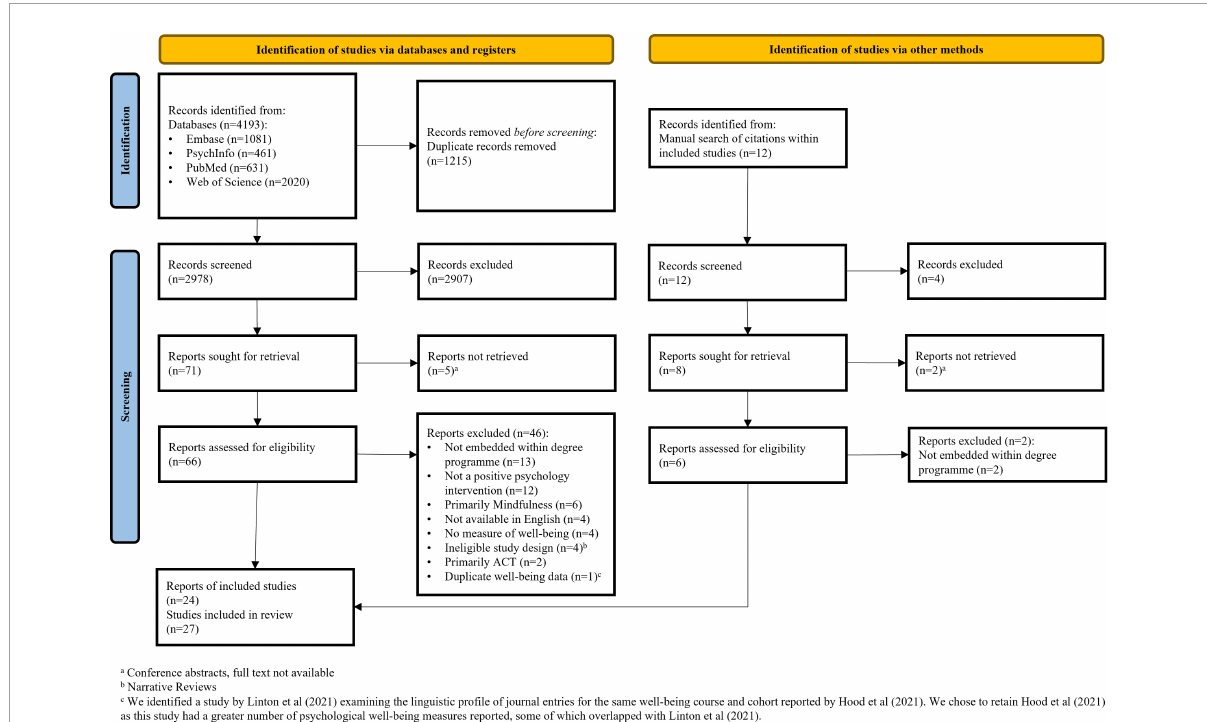
FIGURE1 PRISMA flow diagram illustrating the study search